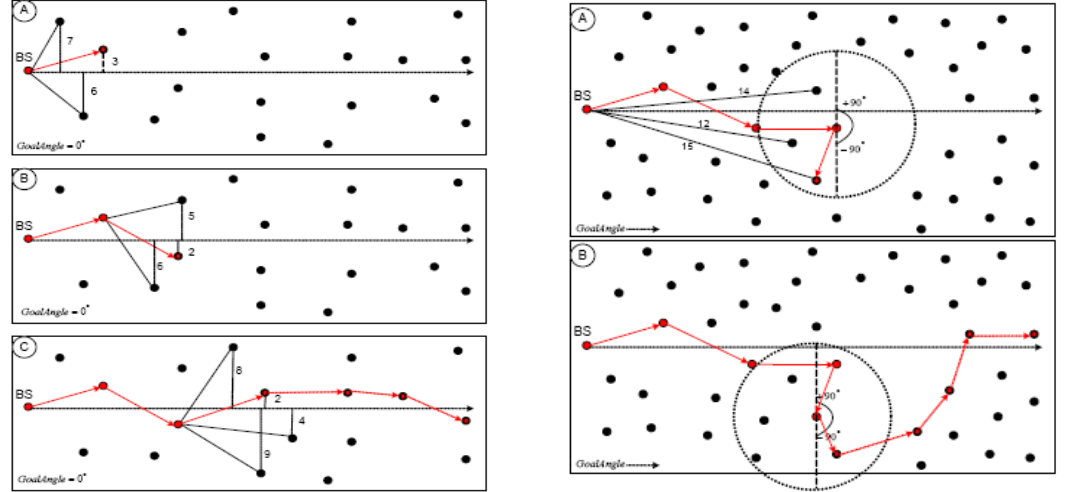
Figure 6. Routing in normal mode [36]. Figure 7. Routing in misroute mode [36].